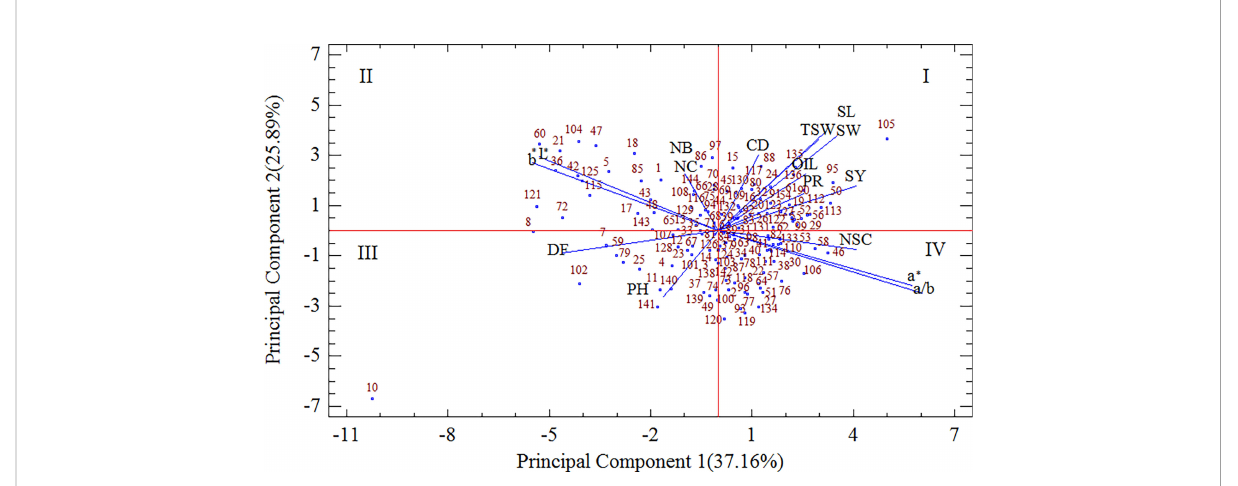
FIGURE 2 The biplot depicting the scatter of 144 fl ax genotypes alongside the measured traits. DF days to fl owering, PH plant height, NB number of branches, NC number of capsule, NSC number of seed per capsule, CD capsule diameter, TSW thousand seed weight, SY seed yield, SL seed length, SW seed width, L*, a*, b*, and a/b color parameters, OIL oil content, PRO protein